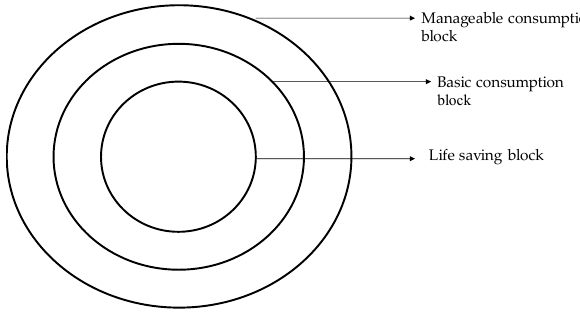
Figure 5. Water quantity and blocks based upon economics of water use. Source: Adapted from Liu [26].